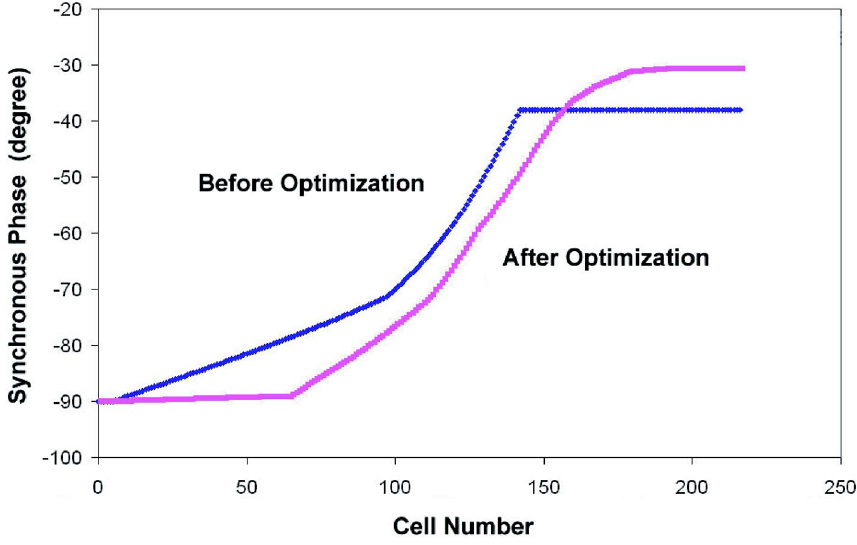
FIG. 1. (Color) Variation of the synchronous phase along the PKU deuteron